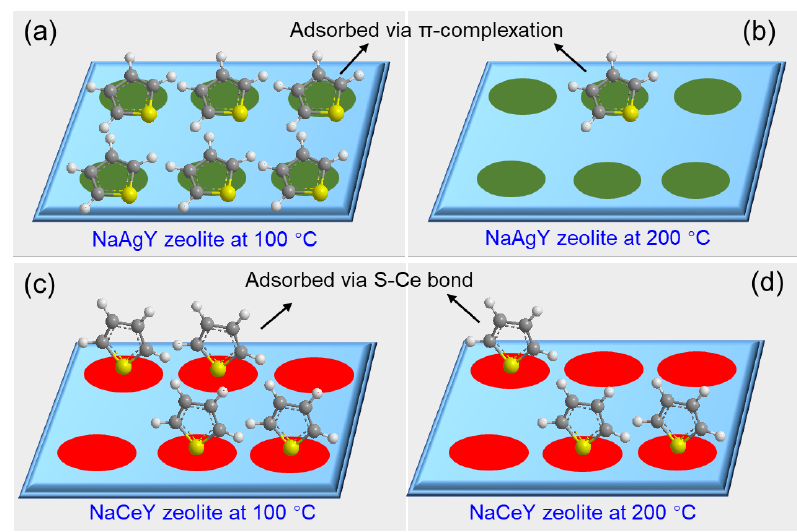
Figure 9. Thiophene adsorption over different NaMY sorbents. ( a ) NaAgY at 100 °C; ( b ) NaAgY at